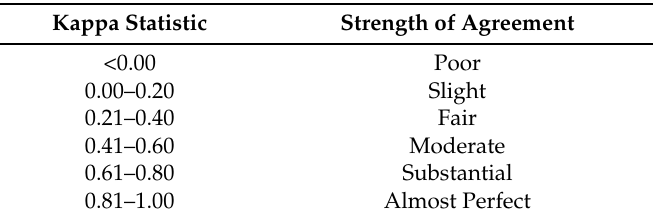
Table 3. Agreement interpretation proposed by Landis and Koch ([45], p.